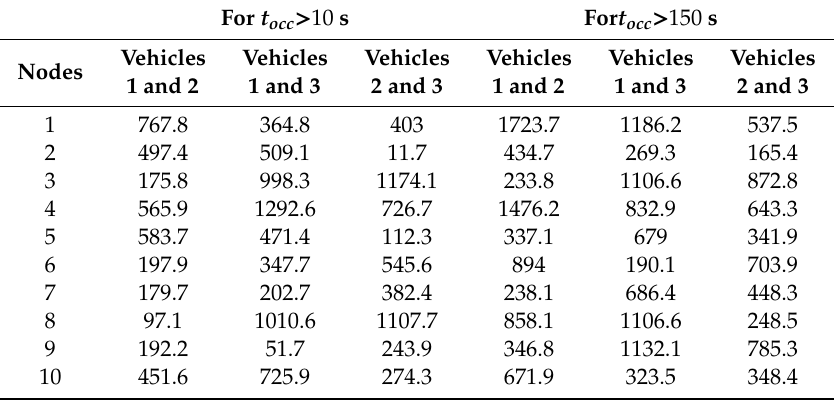
Table 8. Arrival time di ff erence for t occ > 10 s and t occ > 150